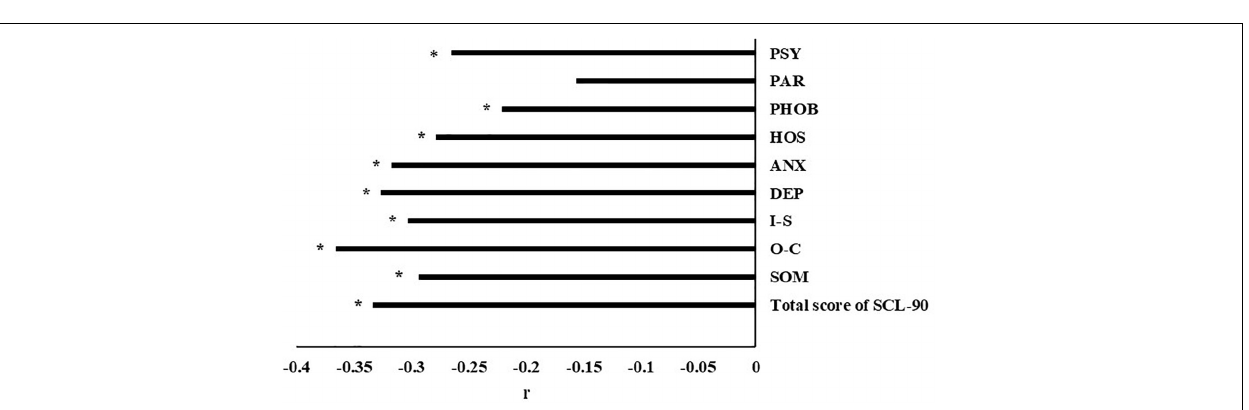
FIGURE 2 | Correlation between total score of SCL-90 and different nut intake groups. Partial r and P -value were obtained after adjustment for the frequency of drug use. SOM, somatization; O-C, obsessive–compulsive behavior; I-S, interpersonal sensitivity; DEP, depression; ANX, anxiety; HOS, hostility; PHOB, phobic